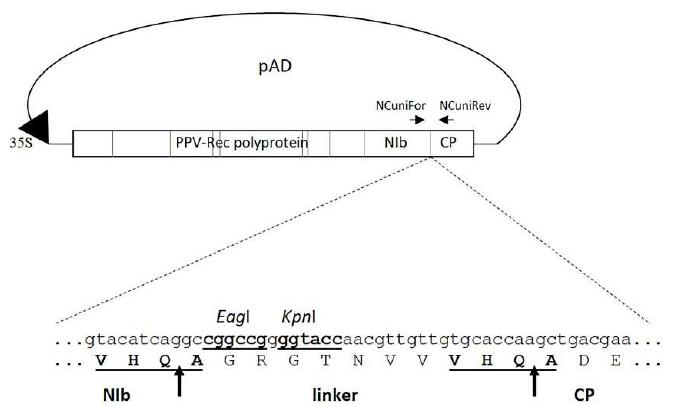
Figure 1. Scheme of the vector pAD. Details of the cloning cassette are shown at the bottom. Restriction sites and amino acid sequences recognized by viral protease are highlighted in bold and underlined. Cleavage positions are specified by vertical arrows. Primer-binding sites for analytical PCR are indicated by horizontal arrows.